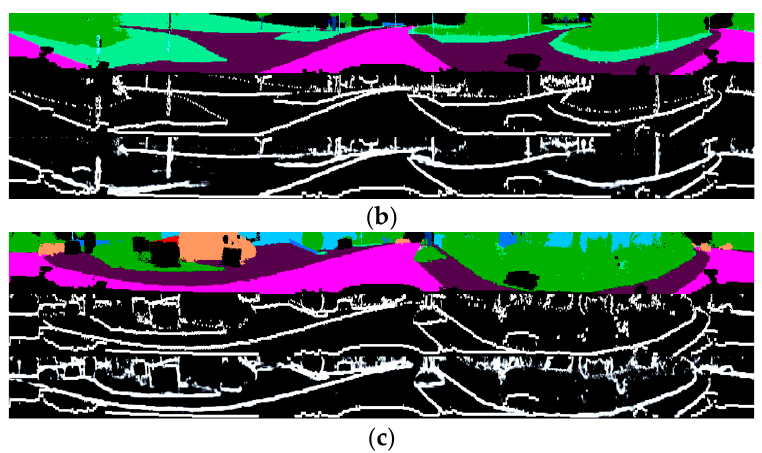
Figure A2. The inpainted GT projection image (first row), GT edge maps (second row) and predicted edge maps (third row) of samples ( a , b , c ) from SemanticKITTI.